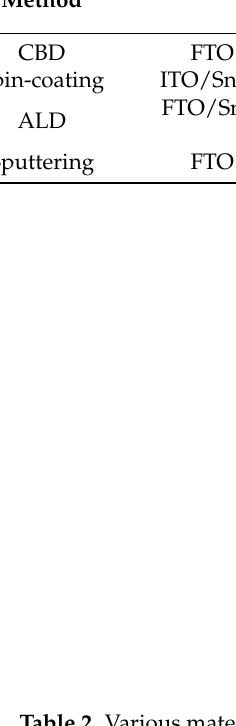
Table 2. Various materials and methods reported for n-i-p perovskite/silicon two-terminal tandem solar cell fabrication.